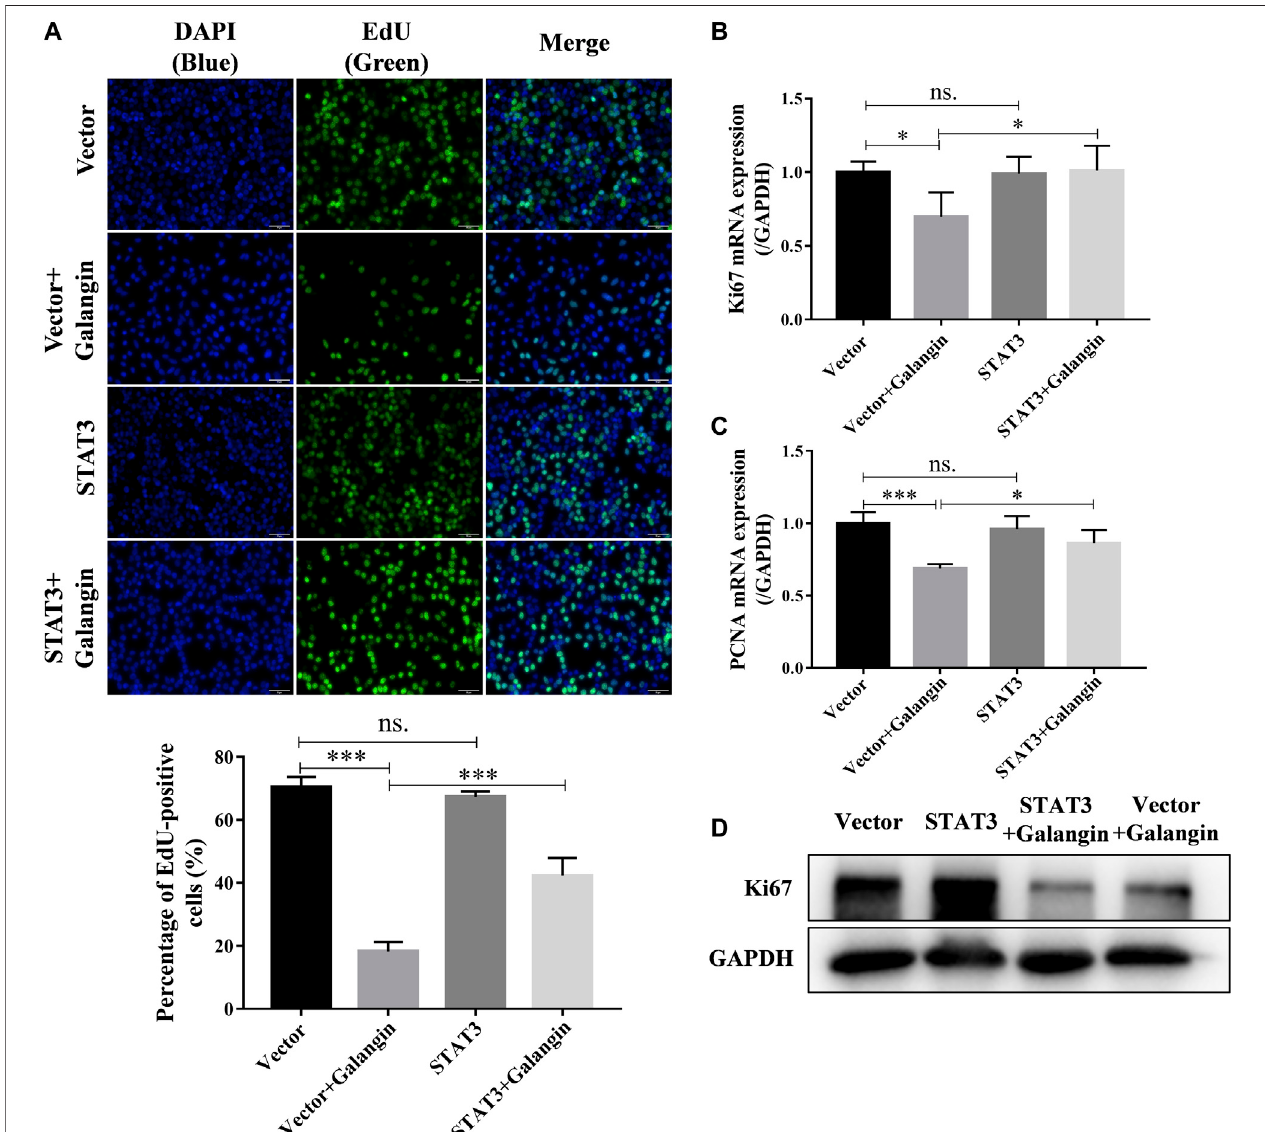
FIGURE 6 | Overexpression of STAT3 counteractes the inhibition of galangin (20 μ M) on cell proliferation of MGC 803 after treatment for 48 h. (A) STAT3 overexpression counteracted the inhibitory effect of galangin (20 μ M) on cell proliferation of MGC 803 cells after treatment for 48 h, detected by EdU staining. (B – C) Overexpression of STAT3 reversed the effect of galangin on the mRNA expression of PCNA and Ki67 after treatment for 48 h in MGC 803 cells detected by qPCR assay. (D) Overexpression of STAT3 reversedtheeffectofgalanginonproteinexpressionofKi67inMGC803cellsaftertreatmentfor48 h.Allofthedatawereshownasmean ± SD,anddifferencesamong ≥ 3 groups ( Figures 6A – C ) were analyzed by one-way ANOVA with Tukey test by using GraphPad 7.0 software; * p < 0.05; *** p < 0.001. n ≥ 3. Scale bar, 50 μ m.